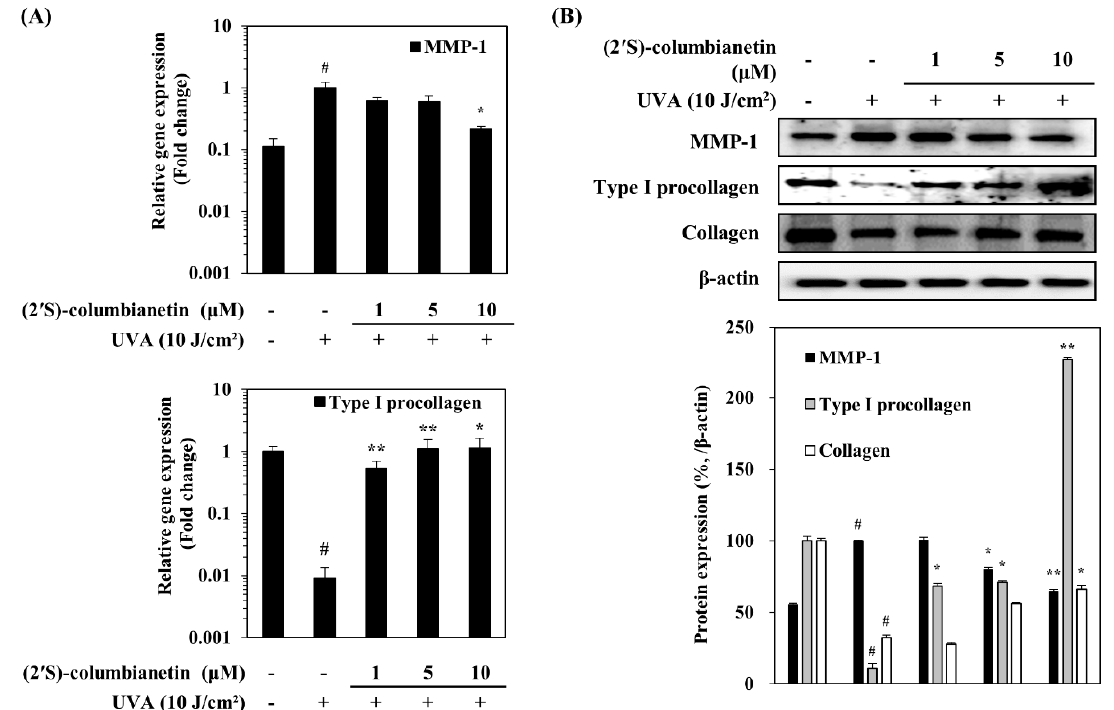
Figure 4. E ff ect of (2 (cid:48) S)-columbianetin on the mRNA ( A ) and protein ( B ) expression levels of the MMP-1 and type I α 1 pro-collagen in UVA-irradiated HDFs after 24 h from treatment analyzed by Reverse Transcription-Quantitative Polymerase Chain Reaction (RT-qPCR) and Western blotting, respectively. β -actin was used as internal loading control. RT-qPCR expression quantity was shown relative to the untreated UVA-irradiated control, calculated by 2 − ( ∆∆ Ct) method. Western blot bands were densitometrically quantified and plotted as relative percentage of UVA-irradiated untreated control group. Values are means ± SD ( n = 3). # p < 0.01 compared to non-irradiated blank group; * p < 0.05, ** p < 0.01 compared to UVA-irradiated untreated control